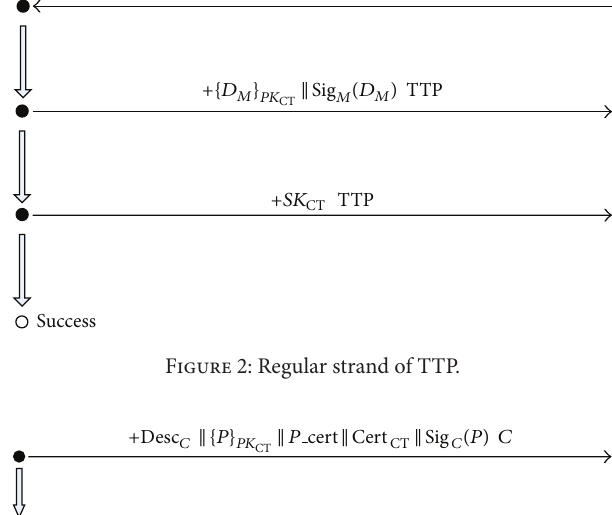
Figure 3: An abnormal-terminated strand of trader 𝐶 .